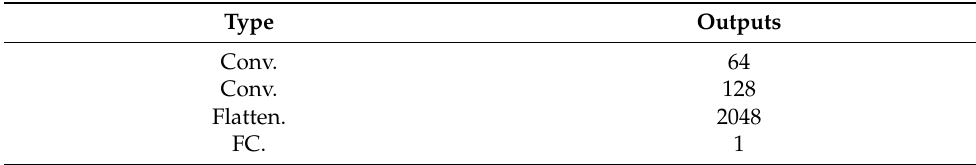
Table 2. Detailed parameters of local discriminator.